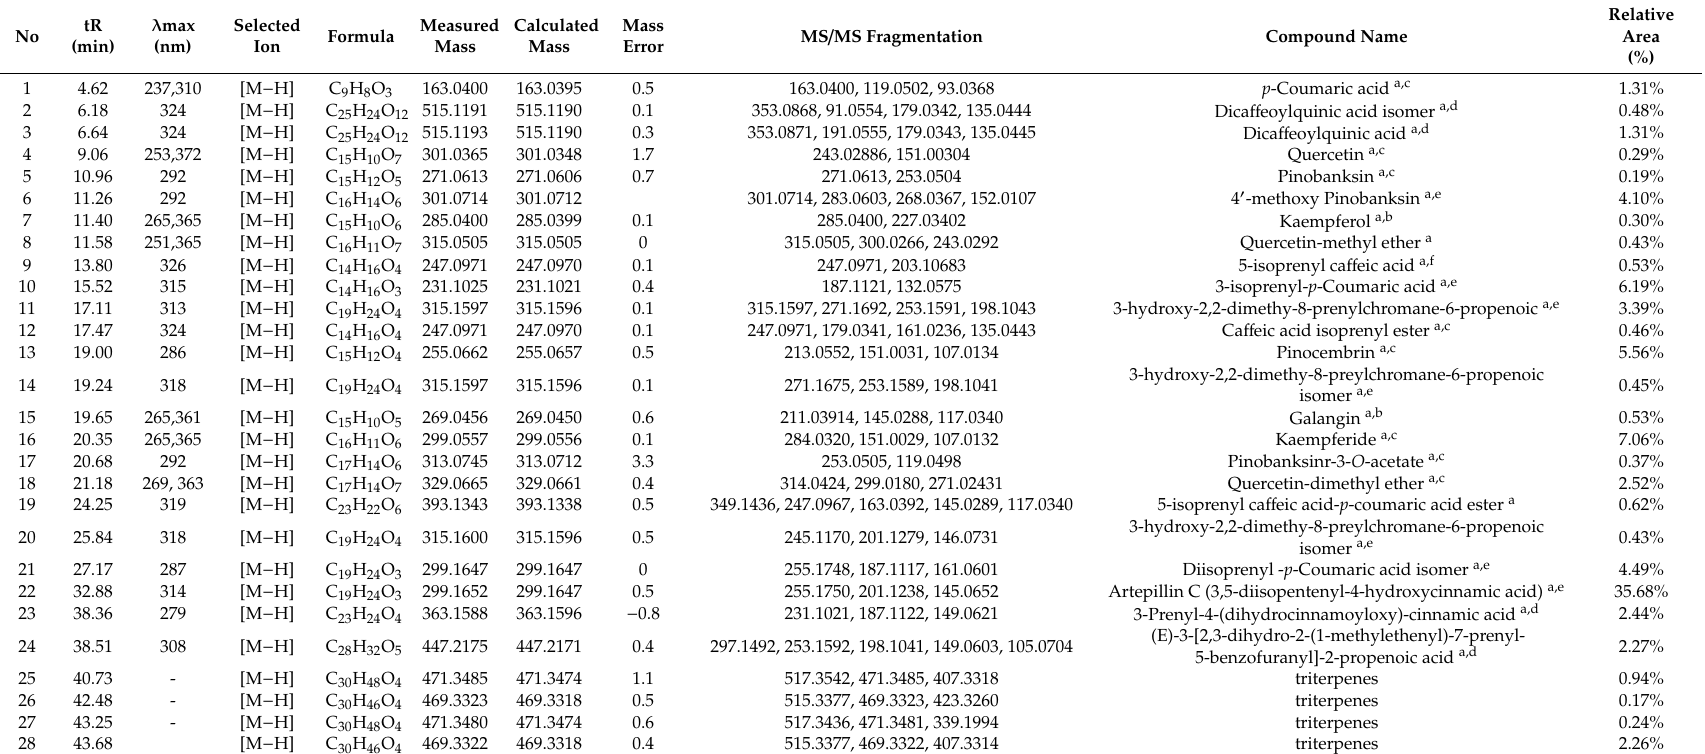
Table 1. Main components of the ethanol extracts of Brazilian propolis